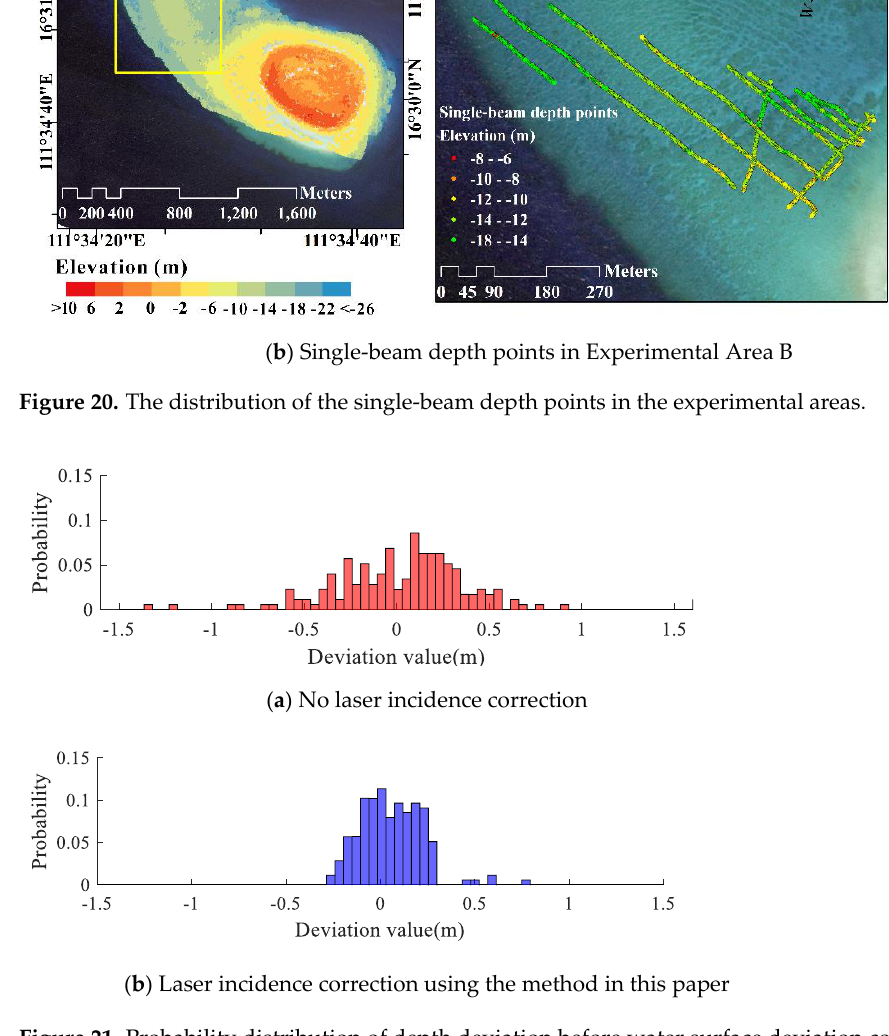
Figure 20. The distribution of the single-beam depth points in the experimental areas.